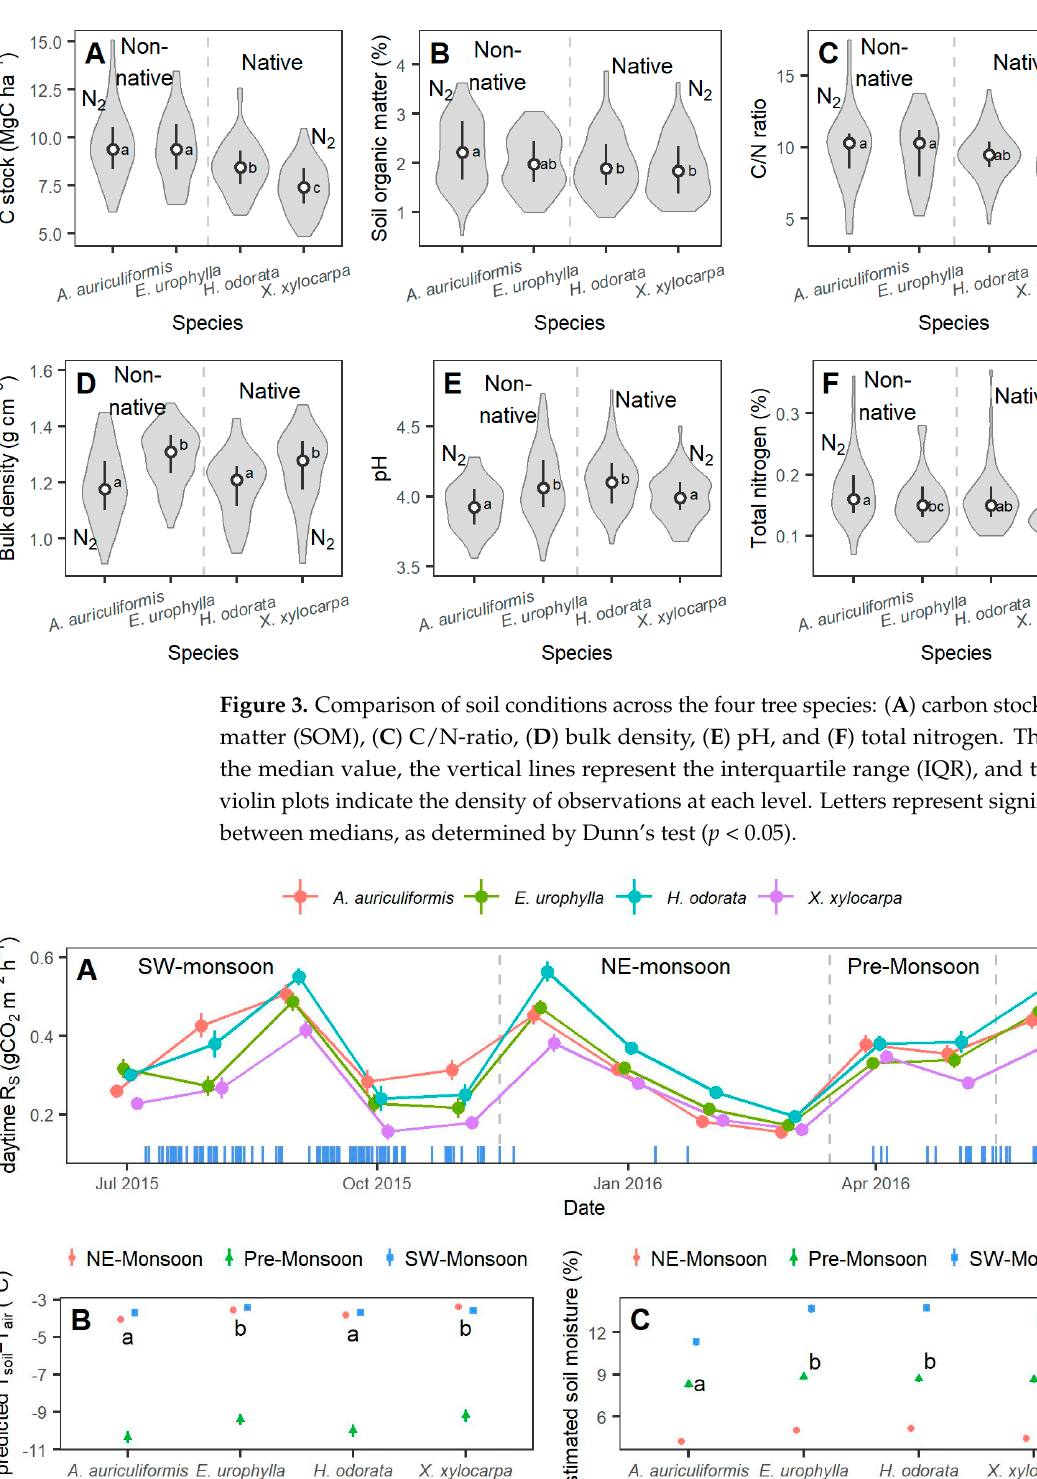
Figure 4. ( A ) Seasonal variation of hourly soil respiration in four monospecific plantation stands measured during the daytime (mean ± 95% CI). The rug plot shows the distribution of days with rainfall over the study period indicating the frequency of precipitation events in the study area. Seasons are indicated above. Seasonal differences between tree species and cooling ( B ) as well as soil moisture ( C ) based on mixed-effects models covering the 1 year sampling period. Letters represent significant differences between means, as determined by Tukey’s HSD test ( p < 0.05).